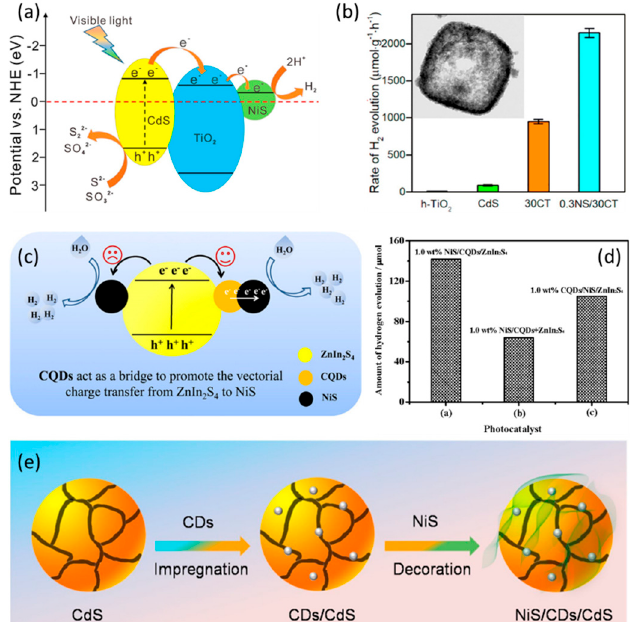
Figure 9. ( a ) Schematic illustration of the photocatalytic mechanism on NiS/CdS/TiO 2 photocatalysts; ( b ) the corresponding H 2 evolution rate of the samples. Adapted with permission from [37]; ( c ) proposed mechanism over NiS/CQDs/ZnIn 2 S 4 nanocomposite for hydrogen evolution; ( d ) the amount of evolved H 2 over different samples. Adapted with permission from [38]; ( e ) schematic illustration for the synthesis of NiS/CDs/CdS photocatalyst. Adapted with permission from [39].